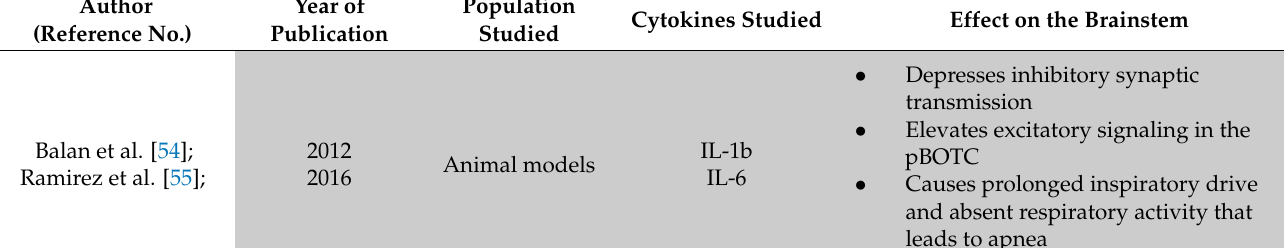
Table 1. Resume of proinflammatory cytokines’ actions on the brainstem respiratory centers and modification of the respiratory activity. Abbreviations as used in the